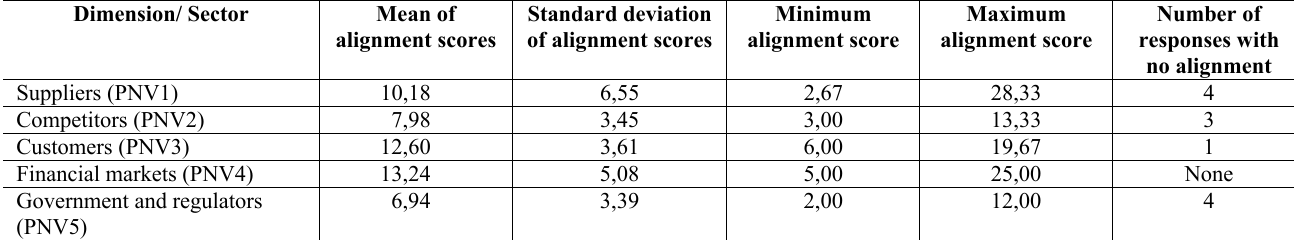
Table5: Descriptive statistics on IS environmental alignment scores (with scores excluding the zero alignment scores) Dimension/